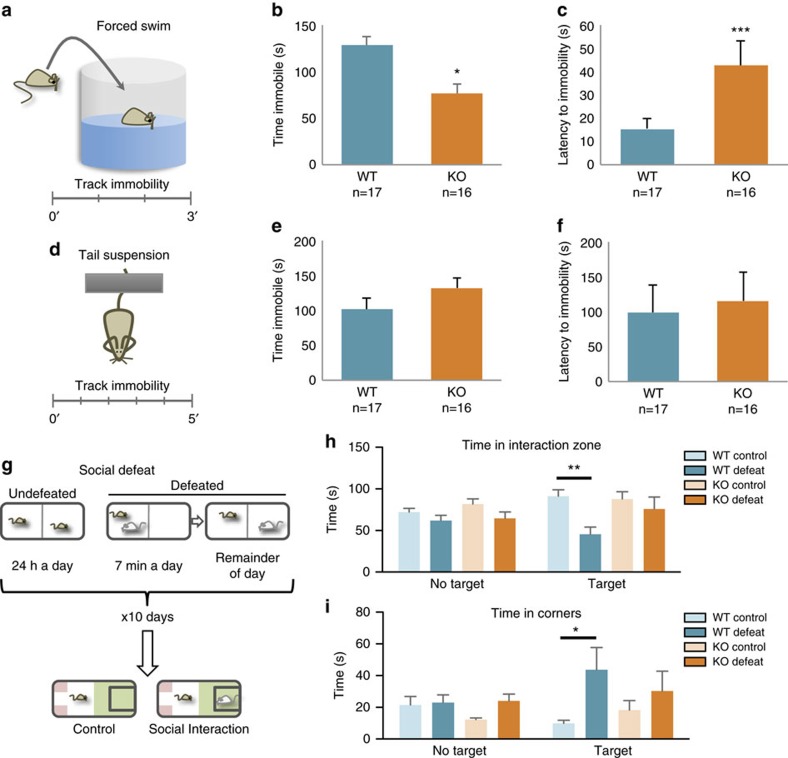
Phf8 deficient mice are resilient to depression.(a) Experimental setup for forced swim assay. Mice are placed in a platform-less beaker filled with water and subsequently monitored for 3 min. (b) Time spent immobile in forced swim assay. (c) Latency to first immobility in forced swim assay. (d) Tail-suspension assay diagram. Mice are taped, suspended by the tail and their immobility is monitored for 5 min. (e) Time immobile in a tail suspension assay. (f) Latency to first immobility for tail suspension assay (g) Experimental design of social defeat assay. Experimental mice are subject to social defeat by exposure to an aggressive mouse over a 10-day training period, then placed with a novel mouse and time spent in the interaction zone (green) versus opposite corners (red) is quantified. (h) Time spent in interaction zone for social defeat assay. Control: no social defeat during training phase, No target: no novel mouse in experimental phase, Target: novel mouse in experimental phase. (i) Time spent in corners during social defeat assay. WT control no target n=10, WT defeat no target n=9, KO control no target n=10, KO defeat no target n=10, WT control target n=10, WT defeat target n=7, KO control target n=10, KO defeat target n=9. Error bars=s.e.m. *=p<0.05, **=p<0.01 (Student's t-test, two-tailed).